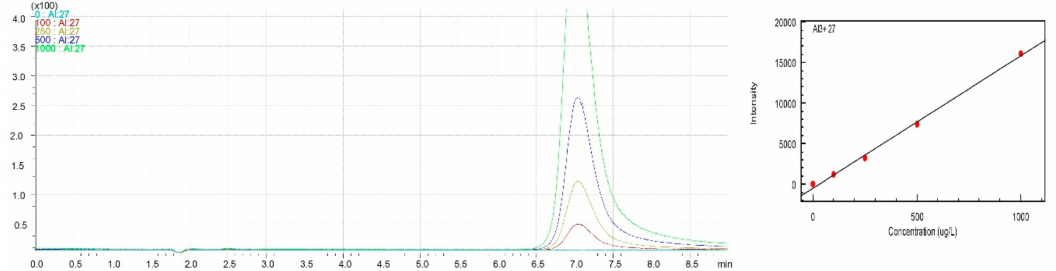
Figure 1. The overlapped chromatograms of Al standards solutions for HPLC–ICP–MS with the use of Hamilton PRP-X200 analytical column and calibration curve of aluminum standard solutions–isocratic